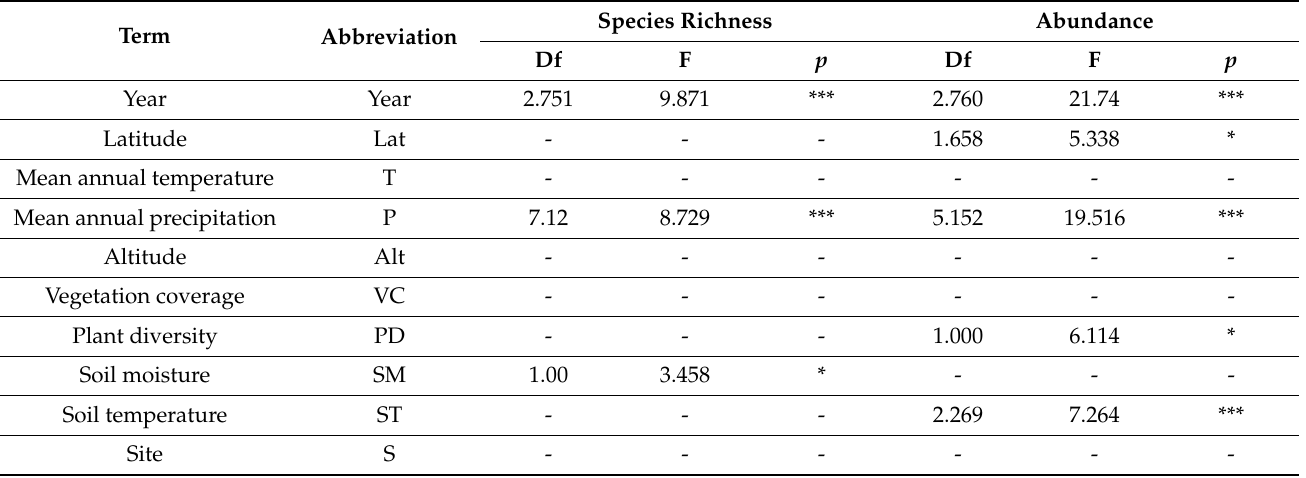
Table 2. Summary of generalized additive regression for the dependent variables of abundance